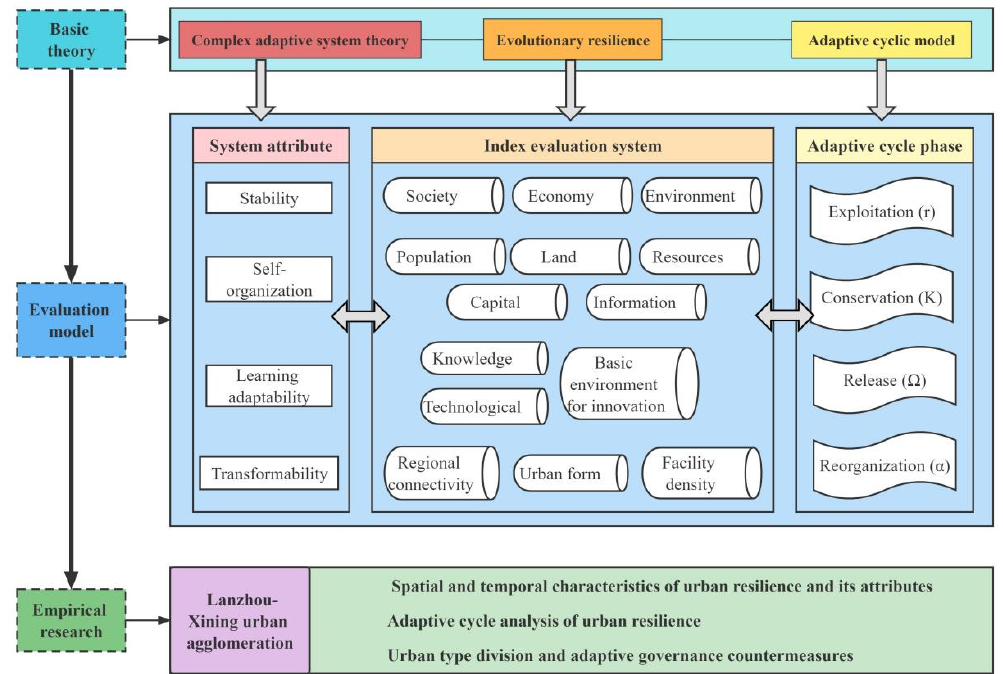
Figure 2. The analytical framework of evolutionary urban resilience.